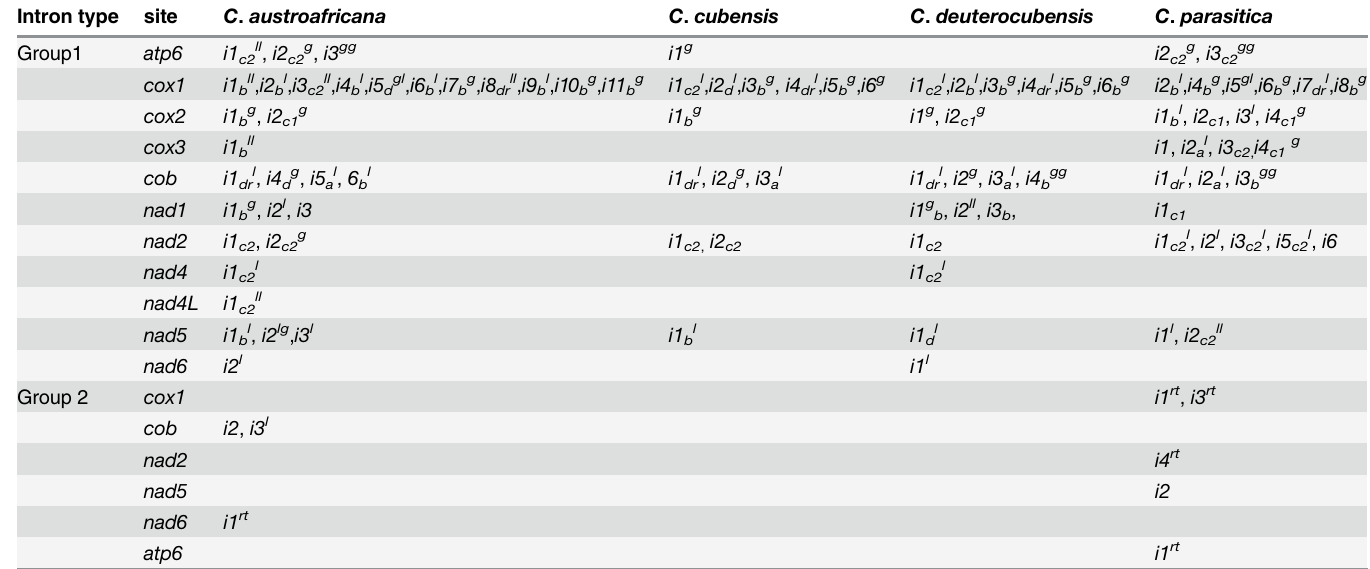
Table 2. Diversity of mitochondrial introns and intron encoded HEGs in the mt genomes of C . austroafricana , C . cubensis , C . deuterocubensis and C . parasitica . Lower case a group stands for group 1A introns, b group 1B, c1 group 1C1, c2 group 1C2, d group 1D, dr group 1-derived introns. Lower case i stands for intron and the numbers indicate intron positions in the respective mitochondrial gene. Superscript letters l , g and rt stand for intron encoded LAGLIDADG, GIY-YIG type HEGs and reverse transcriptase encoding ORFs respectively. Intron